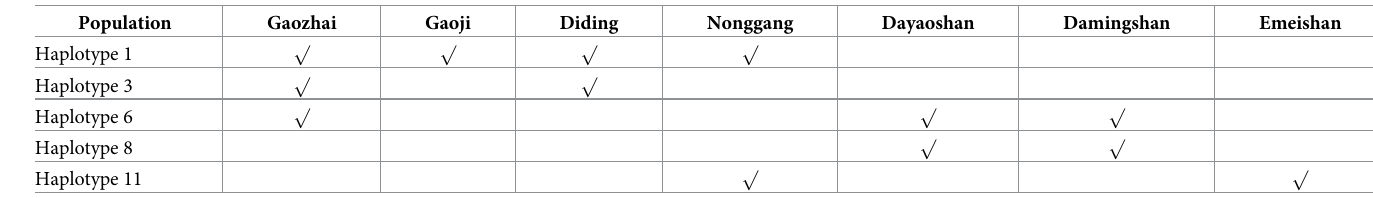
(S11 Table), the putative species 5 consisted of individuals from 3 populations (Dayaoshan, Damingshan and Gaozhai), the putative species 6 consisted of individuals from 7 populations (Gaozhai, Yong’an, Gaoji, Damingshan, Diding, Nonggang, Emeishan), the putative species 7